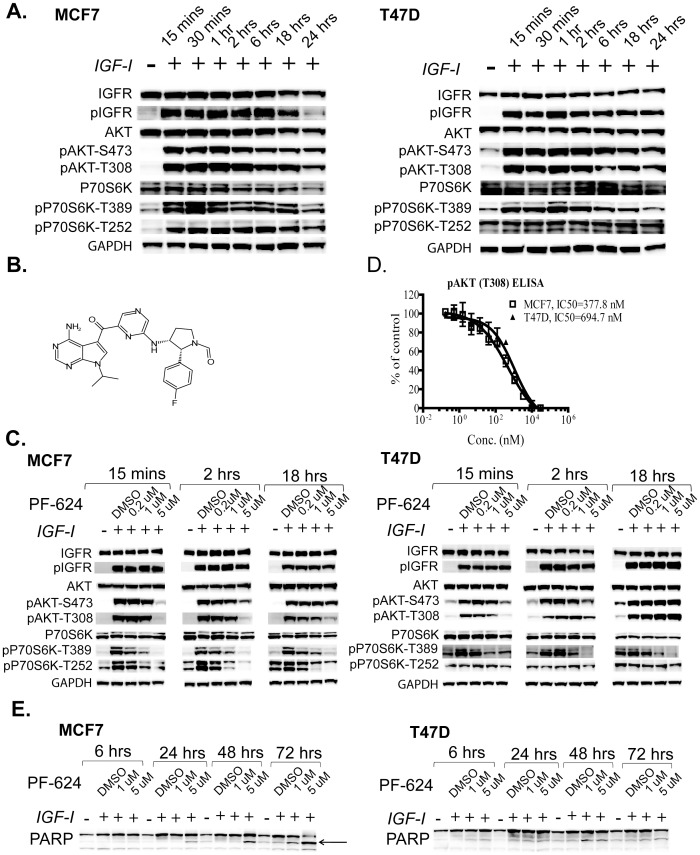
PDK1 inhibitor PF-5177624 decreased IGF-I induced AKT and p70S6K phosphorylation.All IGF-1 stimulation experiments were subject to serum starvation for 24 hours prior to compound treatment or IGF-1 addition. MCF7 and T47D cells were stimulated with IGF-I at various time points, and phosphorylation levels of IGFR-I, AKT and p70S6K were determined (A). The structure of PF-5177624 is shown in (B). MCF7 or T47D cells were pre-treated with the PDK1 inhibitor, PF-5177624 at 0.2 uM, 1 uM, or 5 uM for two hours prior to stimulation with IGF-I as noted. Cell lysates were prepared and subjected to SDS-PAGE. Western blot analysis were performed to determine the phosphorylation levels of IGFR-I, AKT, and p70S6K (C), as well as PARP cleavage (E). (D) Cells were cultured in a 96-well microtiter plate and treated with PF-5177624. After two hours of compound treatment, cells were stimulated with IGF-I (15 minutes) and cell lysates were analyzed by pAKT (T308) ELISA assay to determine the IC50 value of PF-5177624. The data shown for the cell treatments and western blots analysis are representative of at least two experiments.